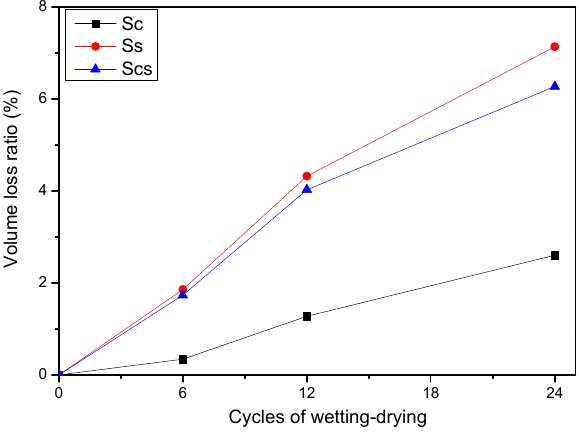
Figure 7. Reconstructed 3D image of the three specimens after 24 cycles: ( a ) Sc; ( b ) Ss; ( c ) Scs.